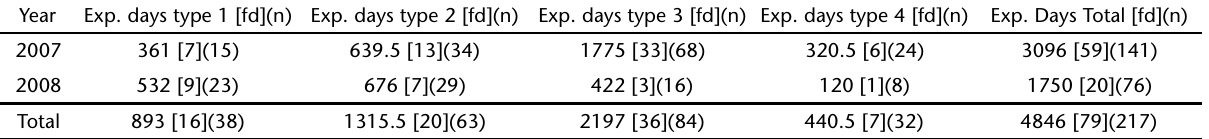
Table I. Sample sizes of observed exposure days in the field for caterpillars of P. papius in four different shelter types built during the larval stage at Yanayacu Biological Station, Ecuador. [fd] represents fatal days, or the number of larvae which died or disappeared during the observation period and (n) indicates the total number of larvae monitored.